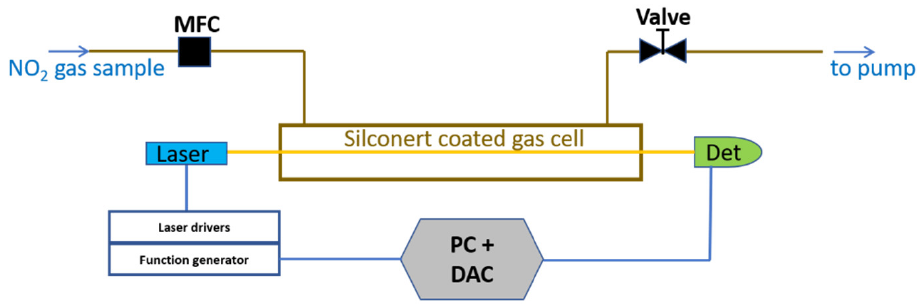
Figure 1. Schematic of the dTDLAS instrument for direct NO 2 measurements (Det: